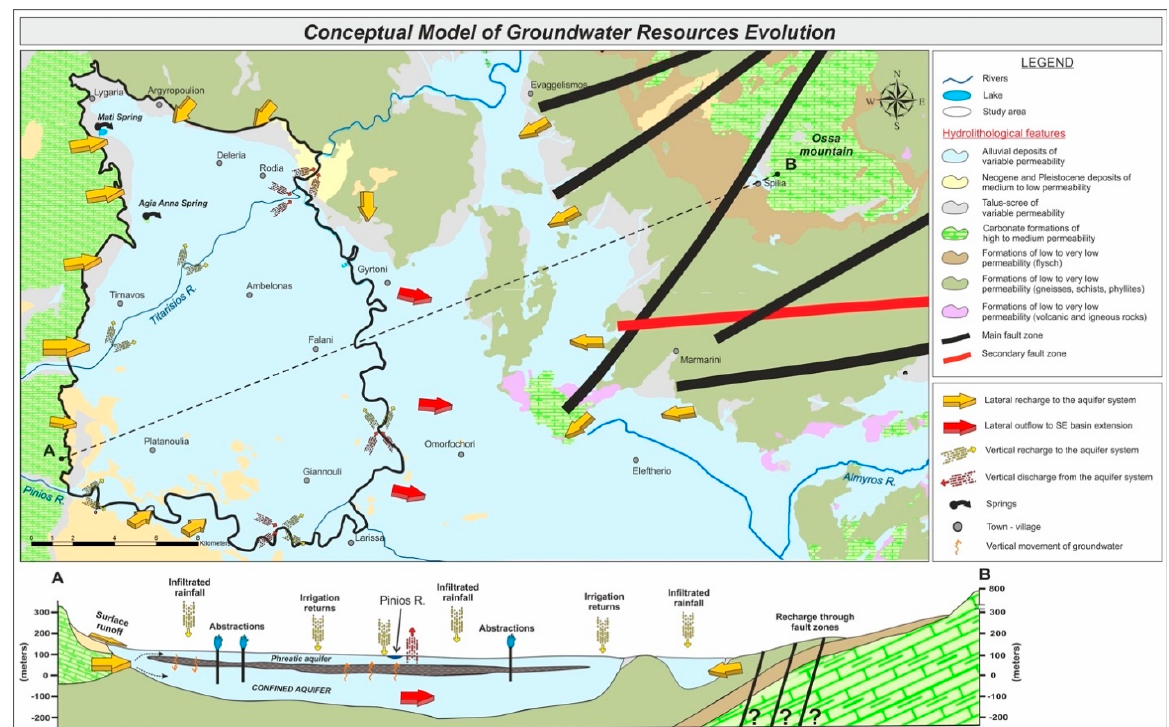
Figure 12. Spatial distribution of δ 18 O for groundwater (April 2018) and conceptualization of geological structure tectonic features and flow paths in the Ossa mountain, after [66].